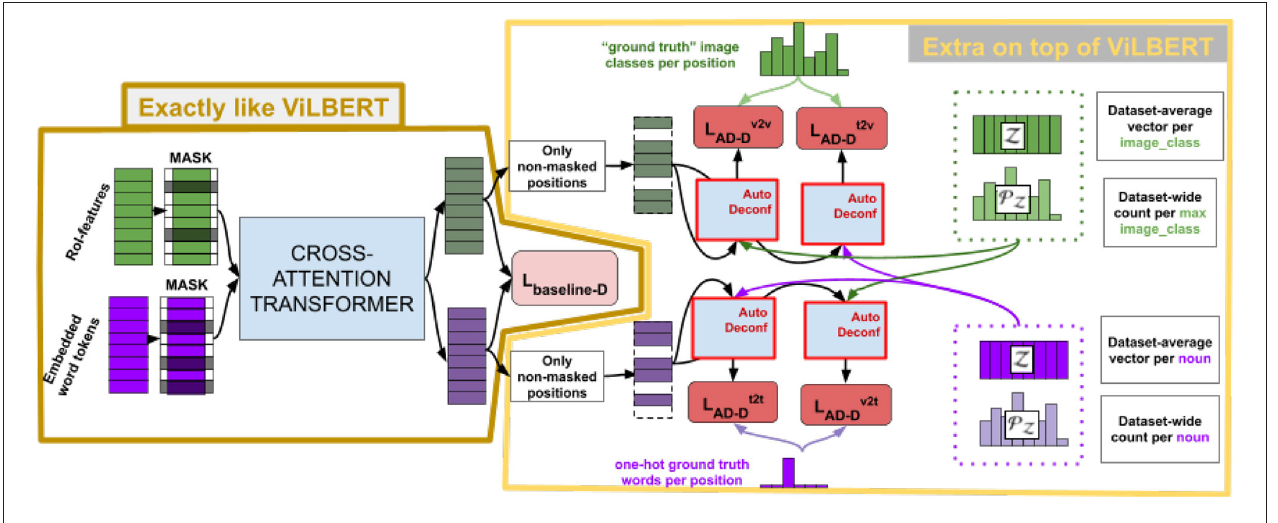
FIGURE 4 | Pipeline for DeVLBERT.